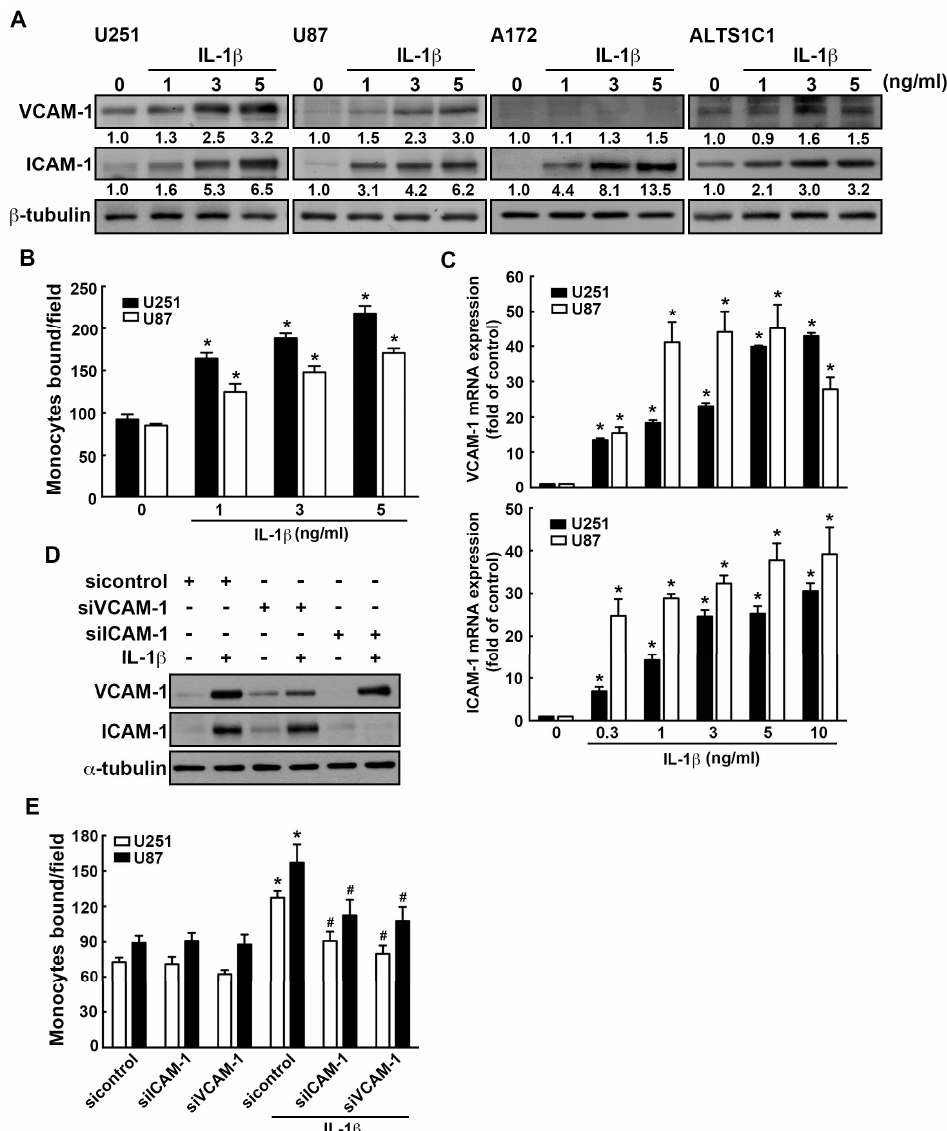
Figure 2. IL-1 β induces VCAM-1 and ICAM-1 expression and increases monocyte adhesion in GBM. ( A ) Four different GBM cells U251, U87, A172 or ALTS1C1 were treated with various concentration of IL-1 β (1, 3, or 5 ng/mL) for 24 h. The expression levels of ICAM-1 and VCAM-1 were assessed by western blotting. ( B ) GBM cells U251 and U87 were added with various concentrations of IL-1 β (1, 3, or 5 ng/mL) for 24 h. BCECF-AM- labeled-THP-1 were added to GBM cells for 45 min, and then the adherence of THP-1 was analyzed using fluorescence microscopy. One-way ANOVA followed by Bonferonni multiple comparison test was used to determine the significance of the data. * p < 0.05 compared with the control group. The data are presented as mean ± S.E.M. (representative of independent experiments = 3) ( C ) Cells were treated with various concentrations of IL-1 β (0.3, 1, 3, 5, or 10 ng / mL) for 6 h, and VCAM-1 and ICAM-1 expression was assessed by real-time PCR. One-way ANOVA * p < 0.05 compared with the control group. The data are presented as mean ± S.E.M. (representative of independent experiments = 3). ( D ) U251 GBM cells were transfected with siRNA against control, ICAM-1, or VCAM-1 for 24 h and added with IL-1 β (3 ng / mL) for another 24 h. VCAM-1 and